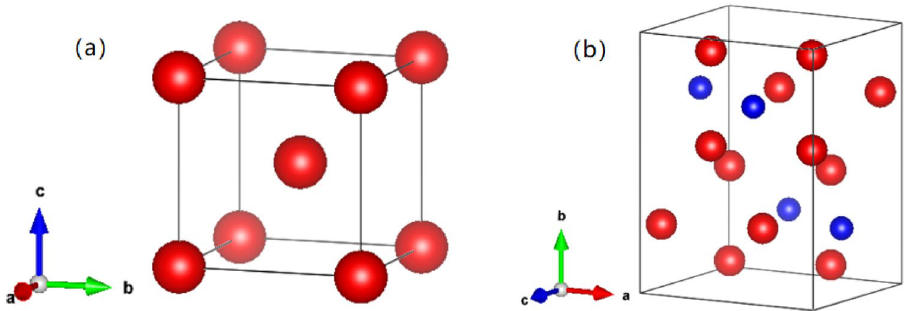
Figure 3. Crystal structure of ferrite ( a ) and cementite ( b ) (red indicates Fe and blue indicates C).